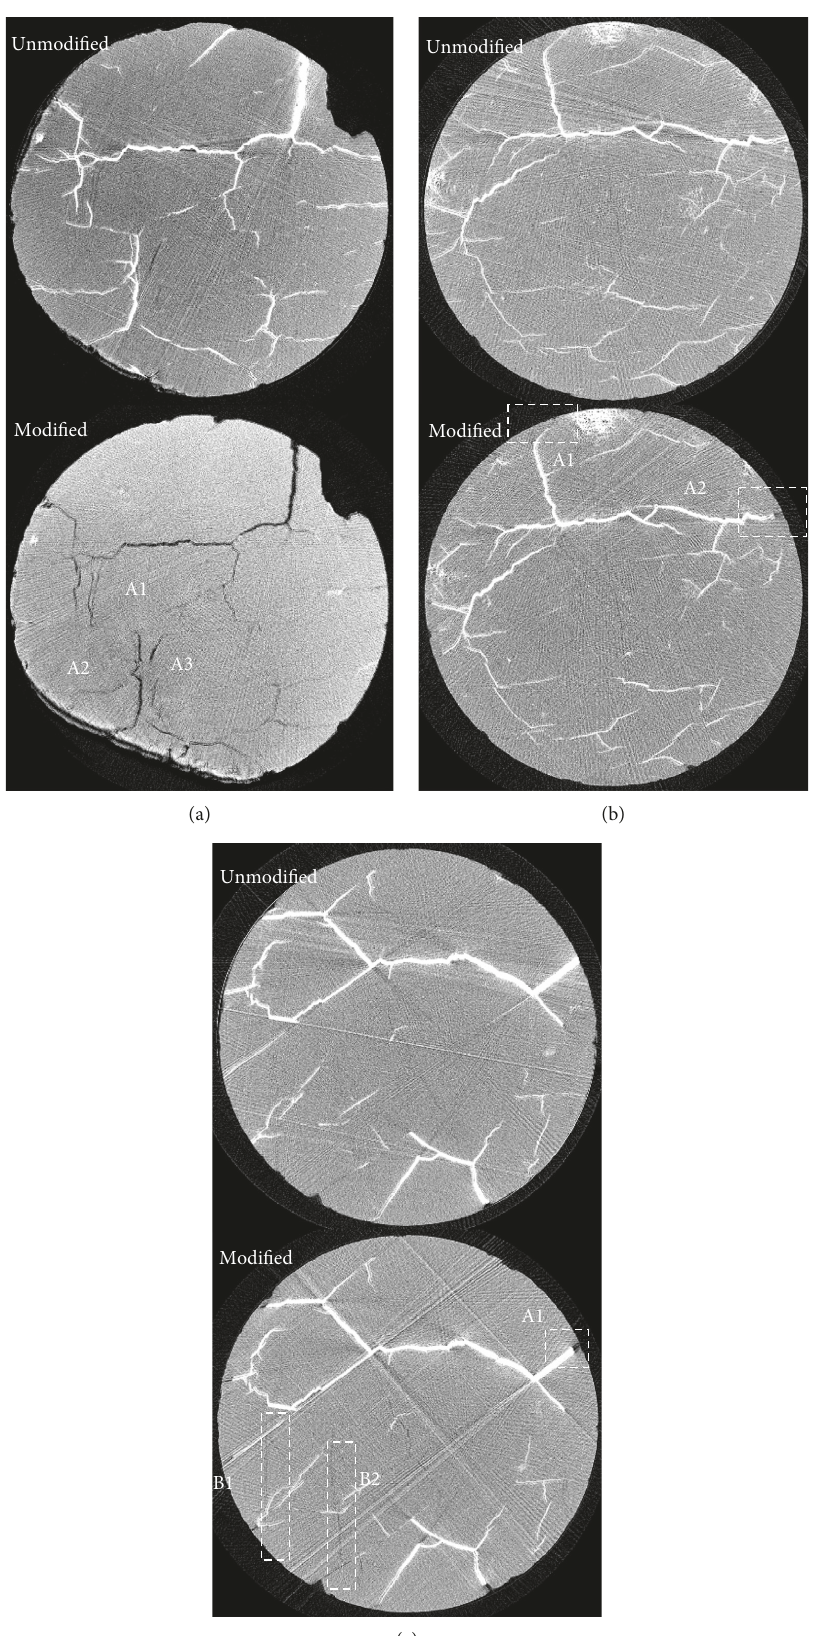
Figure 5: CT image of the structure of coal in the cathodic area after modification. (a) Top section, (b) middle section, and (c) bottom